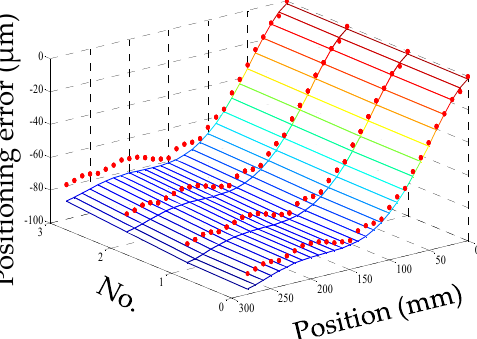
Figure 18. The prediction results of the MLR model (measured positioning error marked with dots) in experiment II.